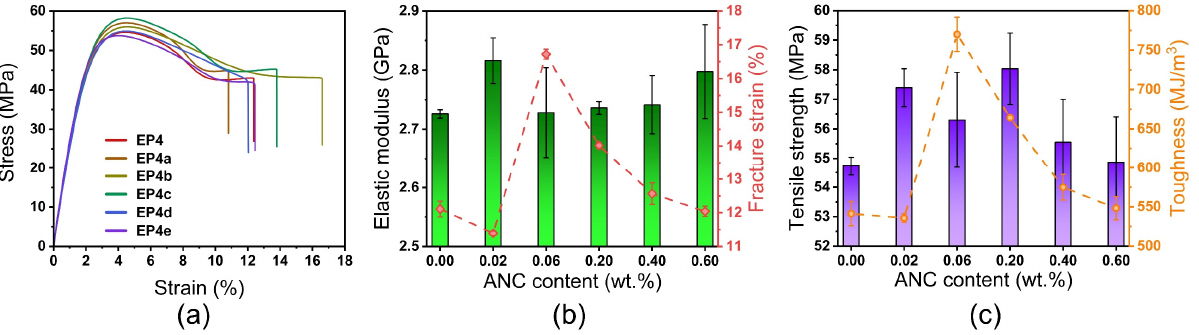
Figure 10. ( a ) Representative strain-stress curves of ANCs incorporated SMEPNs (EP4, EP4a, EP4b, EP4c, EP4d, EP4e, respectively, correspond to 0.00, 0.02, 0.06, 0.20, 0.40, 0.60 wt.% ANCs incorporated in matrix with mole ratio of epoxy monomer to curing agent η = 1.75). ( b ) Elastic modulus and fracture strain of SMEPNs with different ANCs loading. ( c ) Tensile strength and toughness of SMEPNs with different ANCs loading.